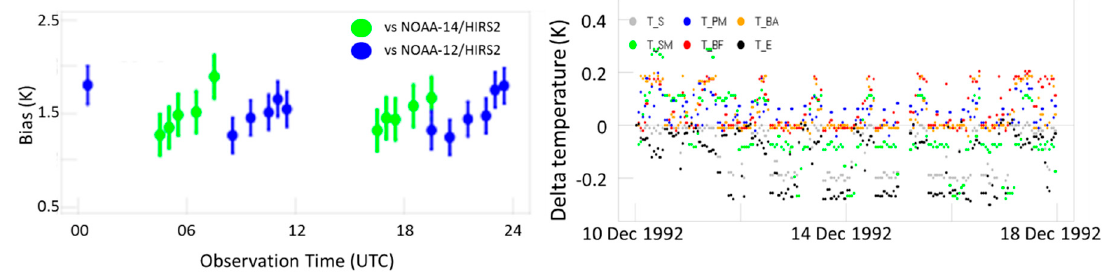
Figure 16. Left panel is the same as Figure 15, but for the IR channel of GMS-4 / VISSR and using collocations HIRS / 2 on NOAA-12 and NOAA-14 during December 1992. The right panel presents, for the five calibration thermometers, the di ff erence between period averaged thermometer temperature and instantaneous thermometer temperatures during eight days in December 1992. Details of each thermometer temperature are shown in Section 2.1.